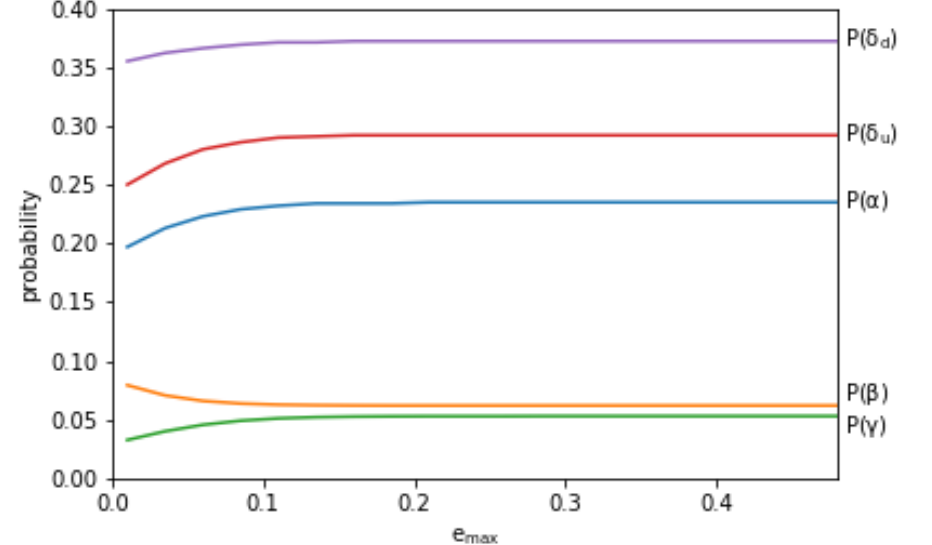
Figure 1. The effect of varying e max on the probabilities of observing our constants. Above e max “ 0.1, probabilities are changed by at most